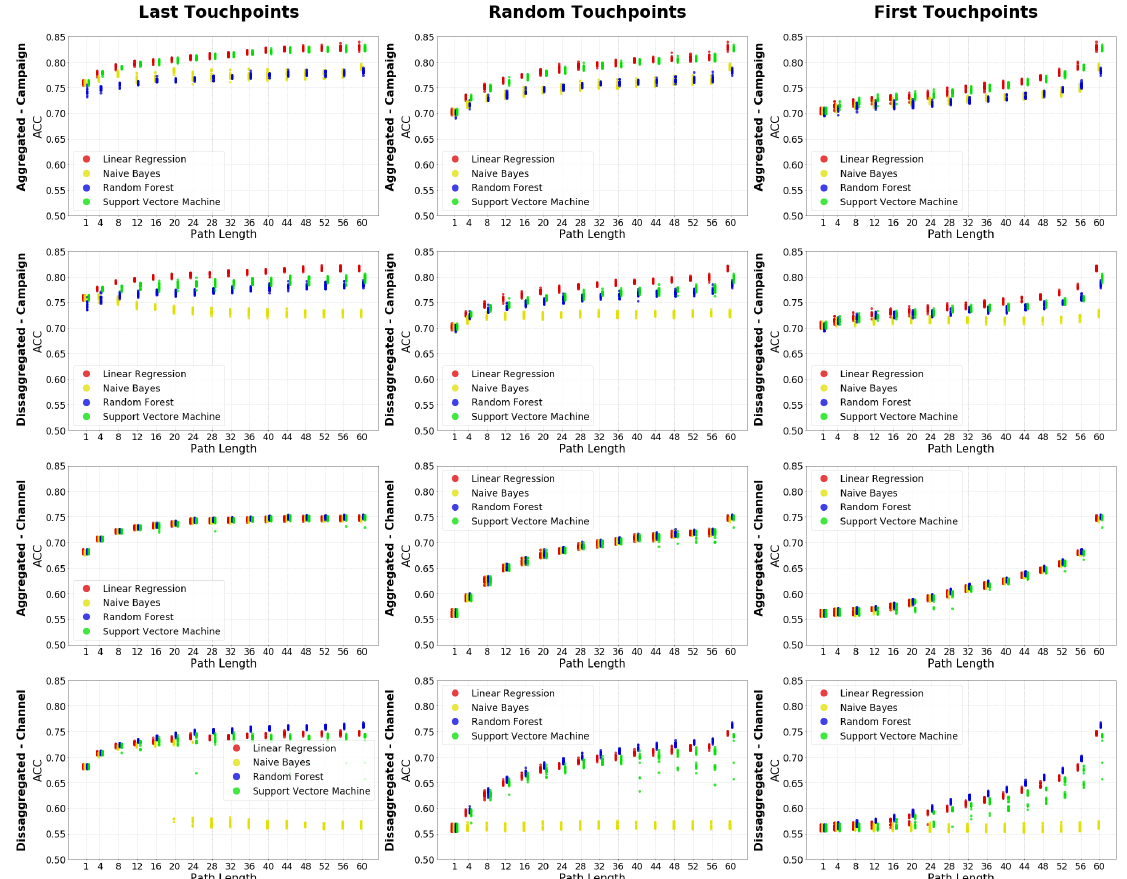
Figure 3. Accuracy of the 4 models in the different use cases. Preferably see it in